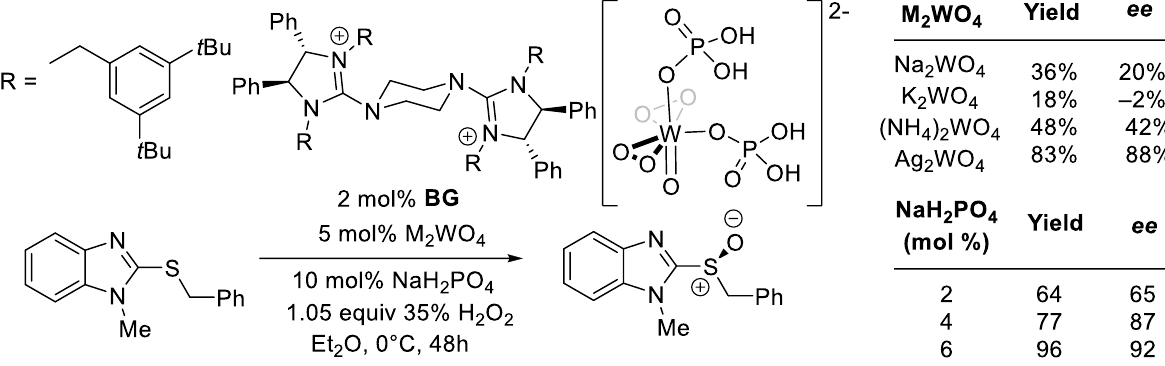
Figure 9. Enantioselective oxidation of sulfide reported by Tan and co-workers [116]. All values are obtained from the mentioned reference.